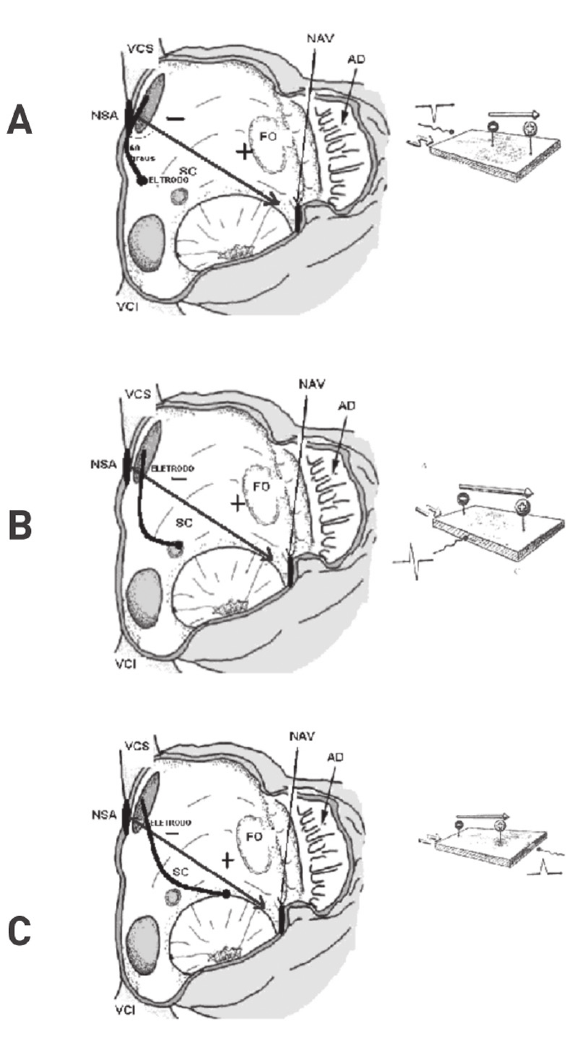
Fig. 4 - Ilustração esquemática da cavidade atrial direita, demonstrando o posicionamento do eletrodo nas regiões alta, média e baixa do átrio direito e o vetor resultante da despolarização atrial direita. À esquerda a ilustração esquemática do eletrograma intracavitário obtido nas três situações. (A) Eletrodo posicionado na região mais posterior ao óstio do seio coronário (átrio direito alto). (B) Eletrodo posicionado em região do óstio do seio (átrio direito médio). (C) Eletrodo posicionado em região mais anterior ao seio do óstio coronário (átrio direito baixo). (SC=óstio do seio coronário, FO=fossa ovalis, VCI=veia cava inferior, VCS=veia cava superior, NAV=nodo átrio-ventricular, NSA=nodo sino-atrial, AD=átrio direito.